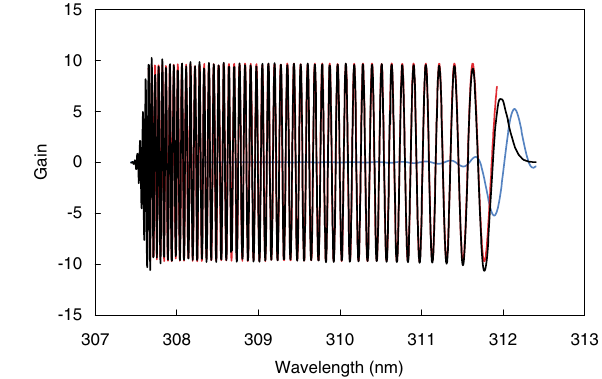
FIG. 3. (Color) Gain versus wavelength (fundamental only). The asymptotic approximation is shown as a black line and the stationary-phase approximation as a red line extending upward from the first peak. The blue line, shifted slightly to the right of the first peak, shows the gain for the equivalent square pulse.